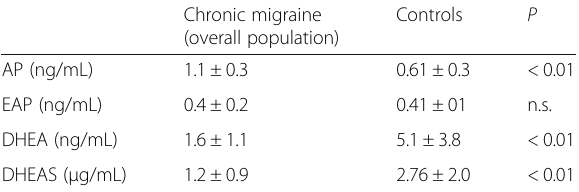
Table 3 Plasma neurosteroid levels in patients affected by chronic migraine patients and healthy